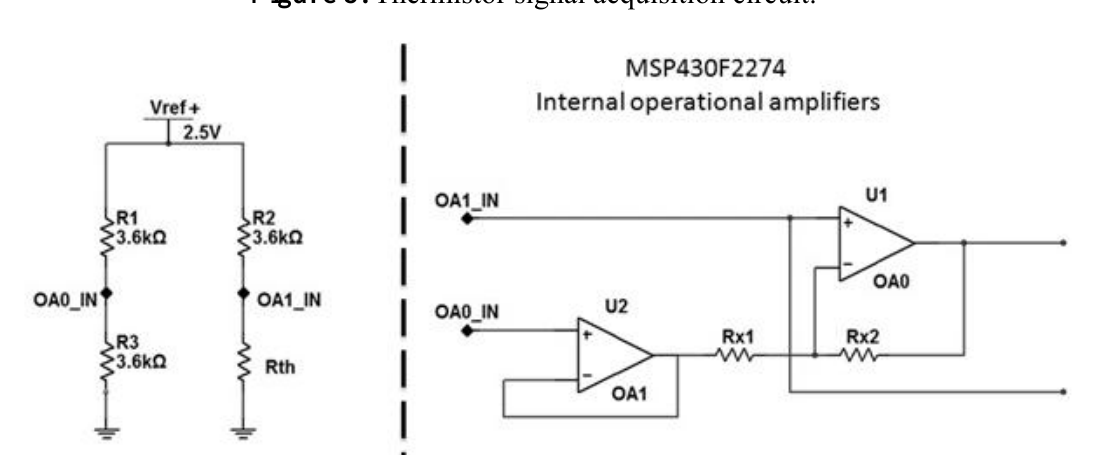
Figure 5. Thermistor signal acquisition